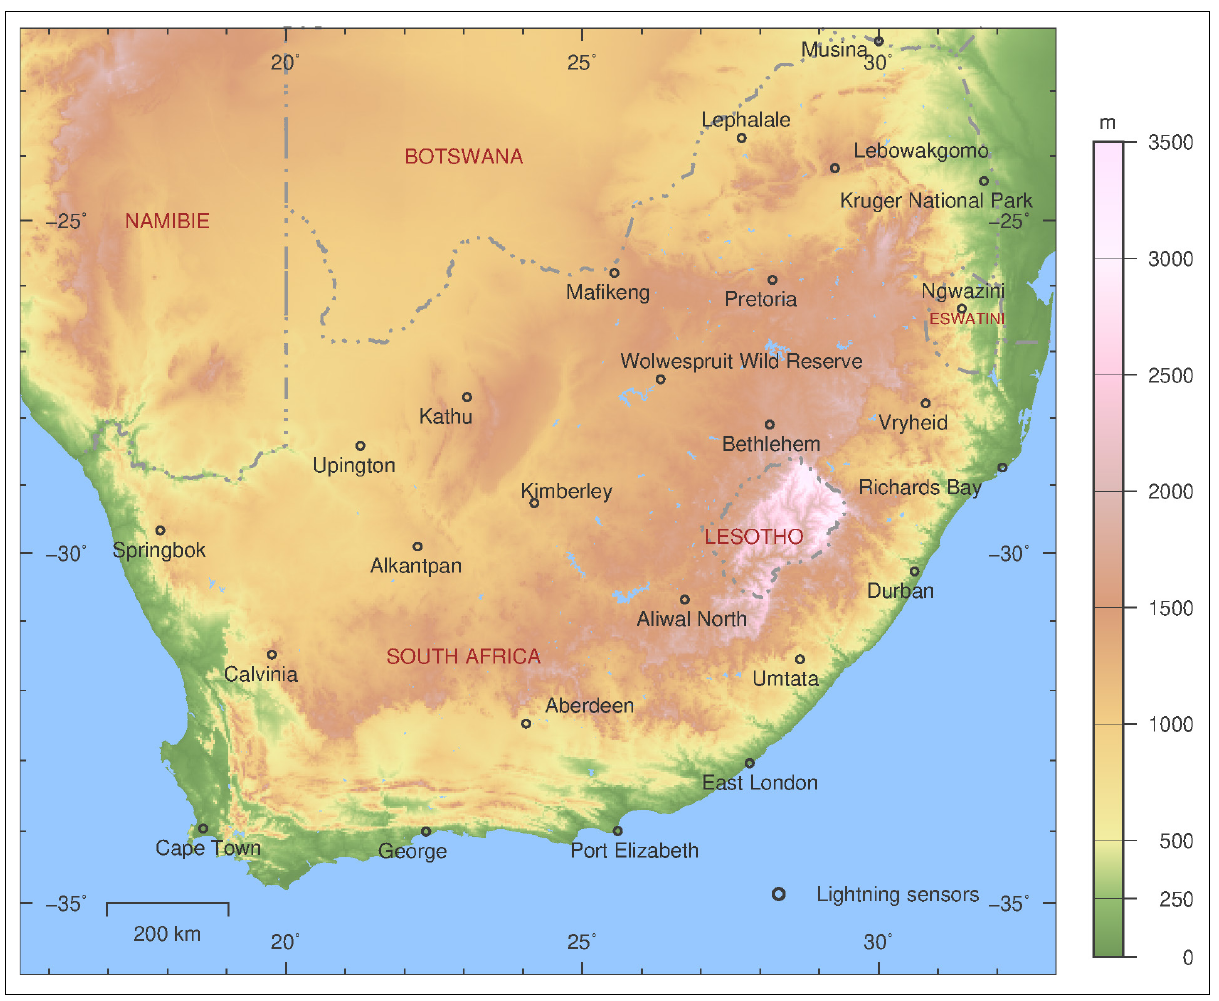
Figure 3: Position of the 25 Vaisala lightning detection sensors over South longitude, and peak ampere. All CG lightning flash data were taken into consideration, regardless of polarity. Annual lightning ground flash density was calculated on 0.1º × 0.1º grid boxes over the country and is expressed in flashes/km 2 . The number of lightning flashes that were recorded by the SALDN over the 8 years (2008–2015) was counted for each individual grid box over the country. The sum of lightning flashes was divided by the area of the grid box to give the number of lightning flashes per square kilometre. To get the average annual lightning flash, the number of lightning flashes per square kilometre was divided by 8, as 8 years of data were considered. All grid boxes were considered, irrespective of the number of flashes. The Grid Analysis and Display System was used to display the lightning ground flash density map. Information on total flash rate and production per flash is needed to quantify LNO production. NO emission factors from the literature and x x CG lightning flash data from the SALDN were used. In South Africa, there have been no studies done to estimate the IC/CG ratio. Therefore, IC/CG ratio estimates from other countries were used for South Africa (Table 1).